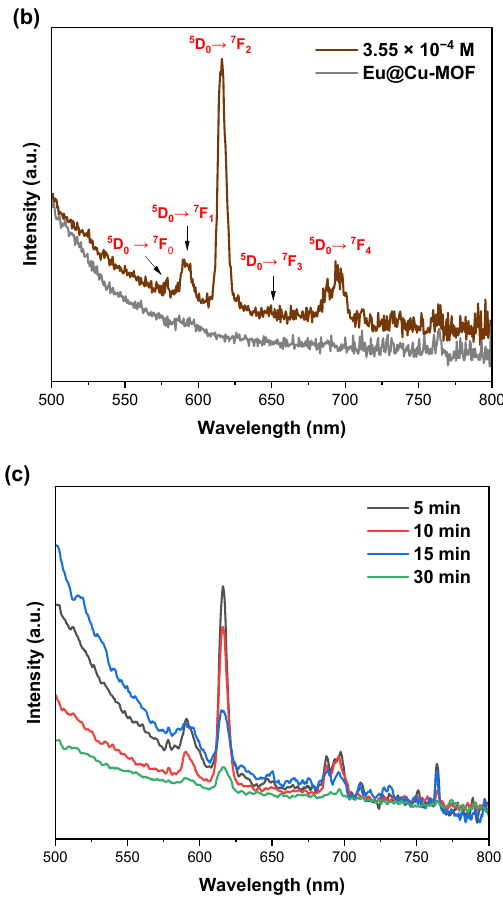
Figure 5. Emission spectra of Eu@Cu-MOF: ( a , b ) for different concentrations of AA (after treatment for 15 min); ( c ) for different times of treatment with AA (C = 7.10 × 10 − 4 M, λ exc = 330 nm).